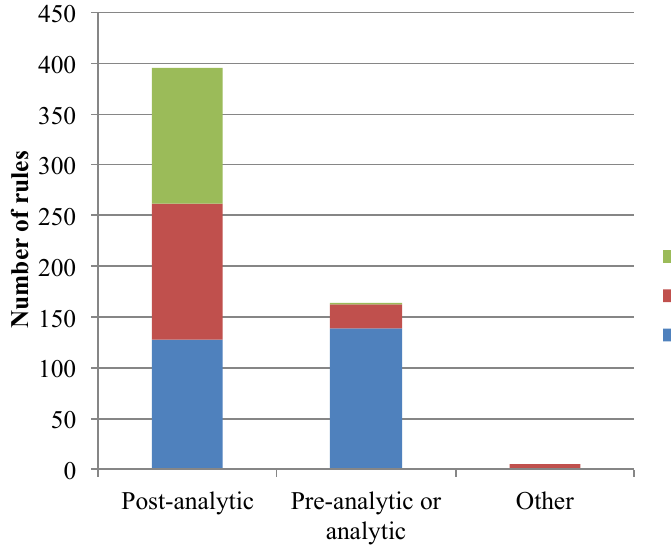
Figure 2. The distribution of 565 IF-THEN rules across phases of genetic testing, stratified by user interface presentation type (warning, recommendation or information